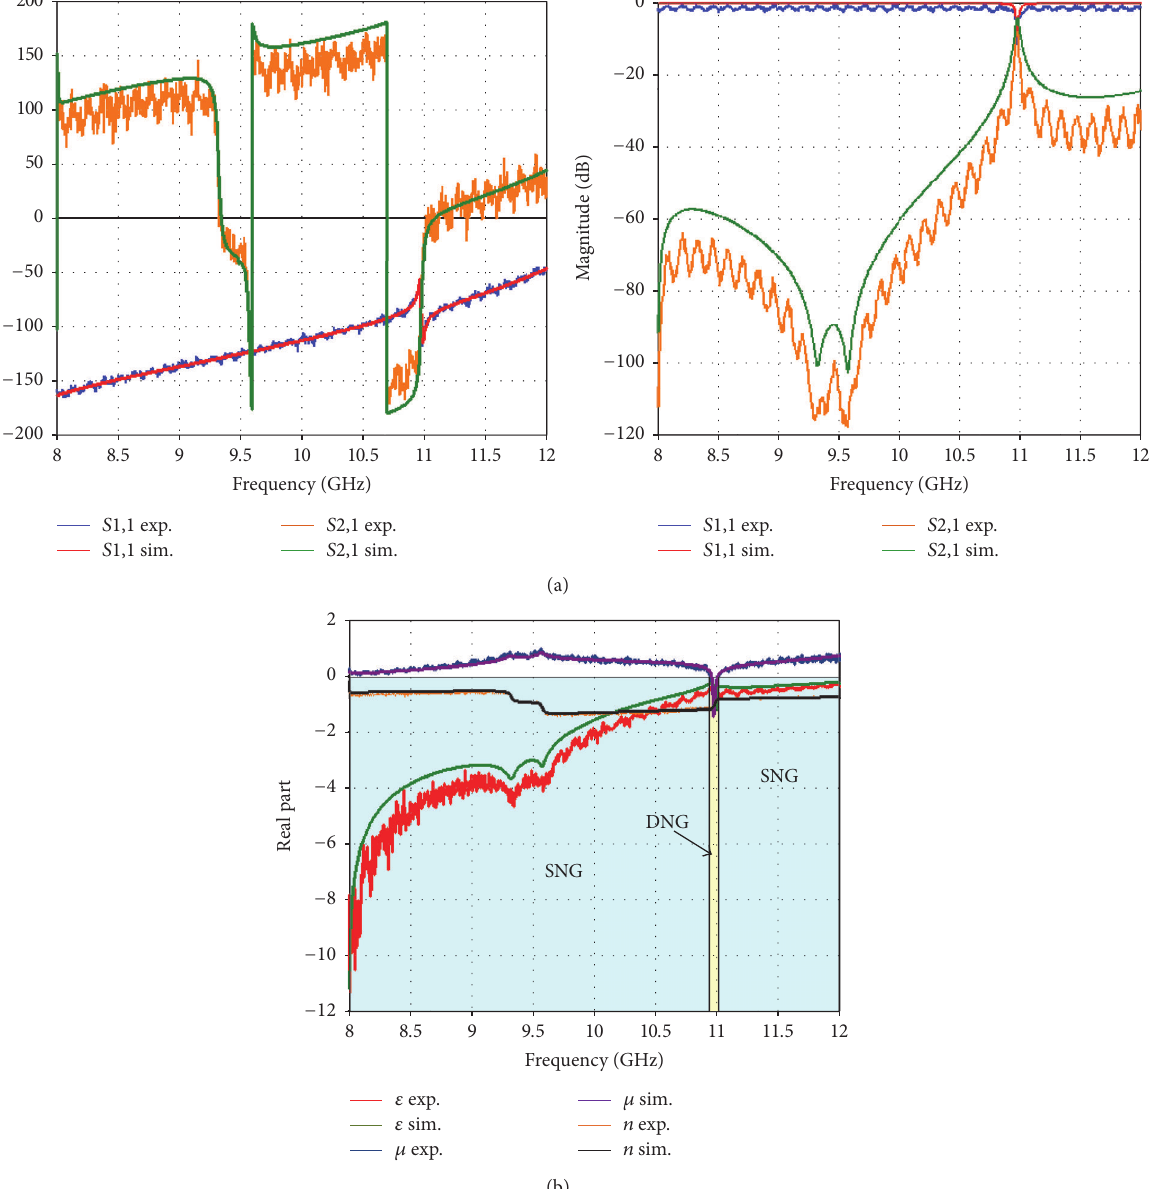
Figure 5: Comparison between simulation and measured results. (a) The Fishnet-Mushroom-like MTMs’ 𝑆 -parameters. (b) Retrieved characteristic